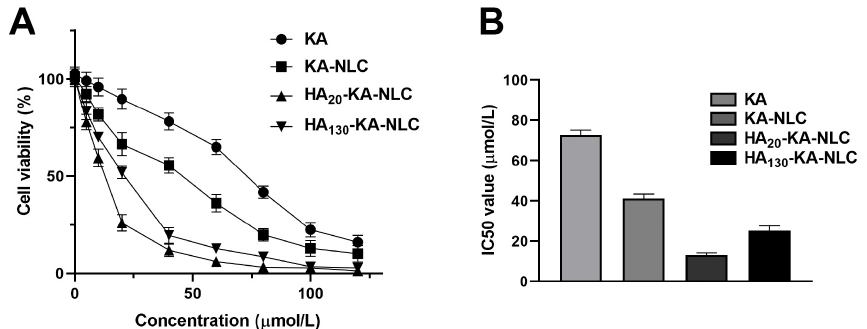
Figure 7. CCK-8 assay was performed in A549 cells with KA, KA-NLC, HA 20 -KA-NLC, and HA 130 - KA-NLC treatments. ( A ) The cell viability treated by different preparations with different concen- tration in A549 cells. ( B ) The 24 h IC 50 values in A549 cells treated by different preparations. The data are presented as the mean ± SD ( n = 3).